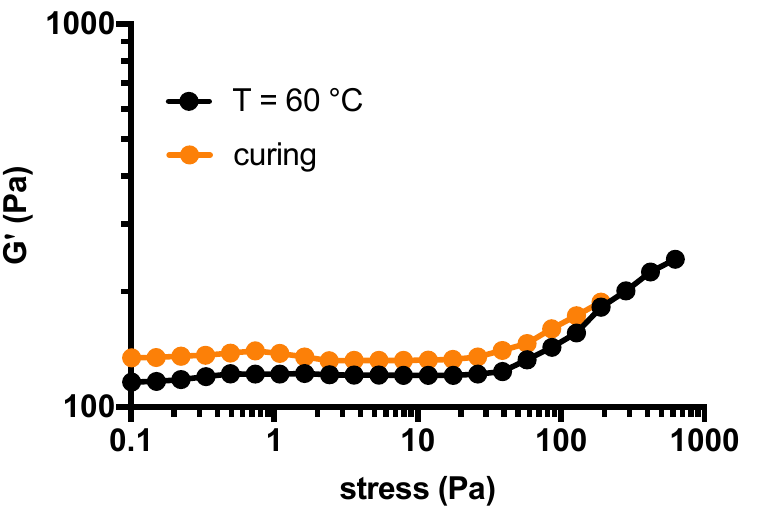
Figure 6. Dependence of storage modulus ( G ′ ) as a function of stress for genipin-based chitosan hydrogel from ACh1 cast at 60 °C (black) and after a curing at 37 °C for 24 h (orange).